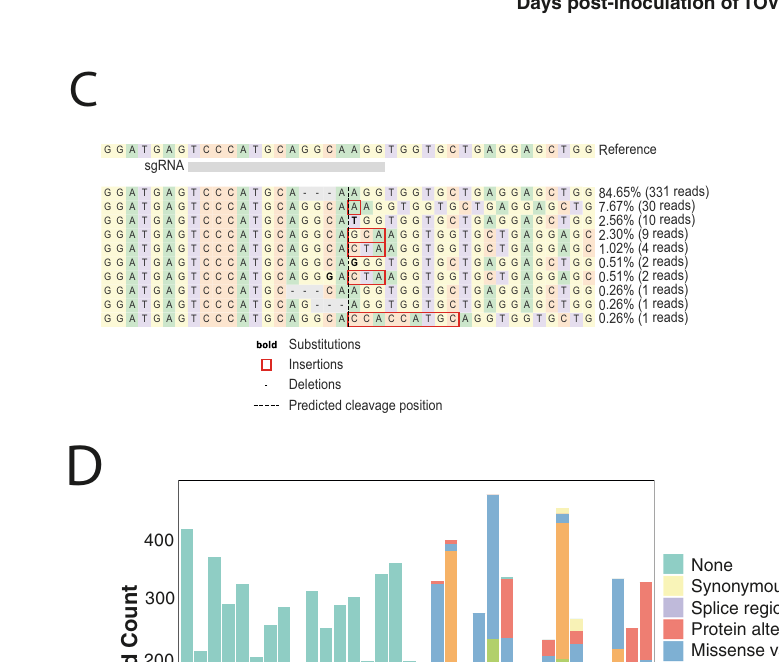
cell line models. Using the TOV21G cell line (constitutively lacking FAM50B expression) or a CRISPR engineered FAM50B null A375 clone (A375- F50B − ), we introduced a lentiviral vector carrying a gRNA to disrupt either FAM50A or a non-essential gene ( AIPL1 ) and cultured the cells for 8 days prior to transcriptome sequencing. In both cell lines, gene set enrichment analysis revealed that disruption of FAM50A on a FAM50B null background resulted in statistically signi fi cant ( p adj < 0.05)